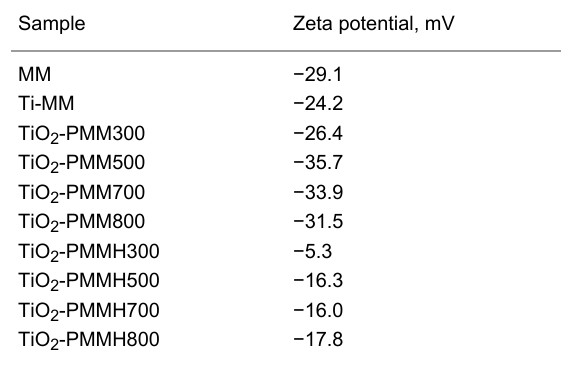
Table 3: Average values of the zeta potential for the samples tested in this